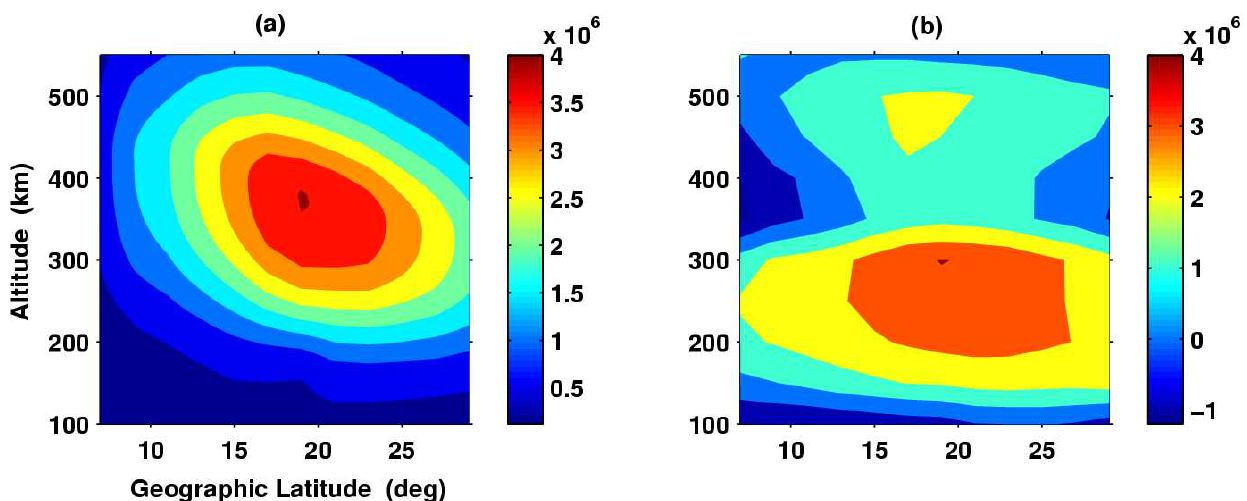
Fig. 14. ( a ) The model with an enhancement in electron density, used to study the discretization error. ( b ) The tomographic reconstruction corresponding to Fig.